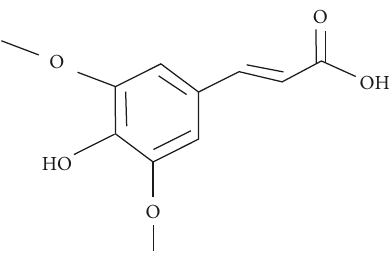
Figure 9: Chemical structure of sinapic acid.